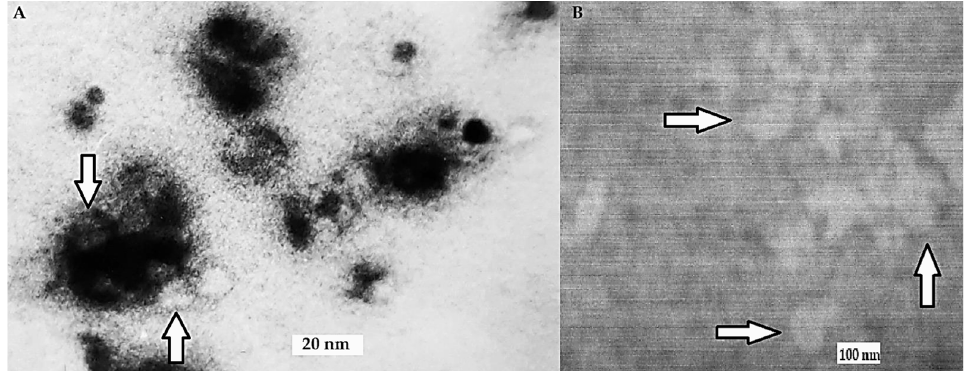
Figure 6. Complexes observed using TEM. ( A ). Heat aggregated immunoglobulins (HAI) with CR; ( B ). HAI without CR. Clusters of supramolecular Congo red can be distinguished around antibodies (darker spots).The images of immunoglobulins (brighter spots) are indicated by arrows.